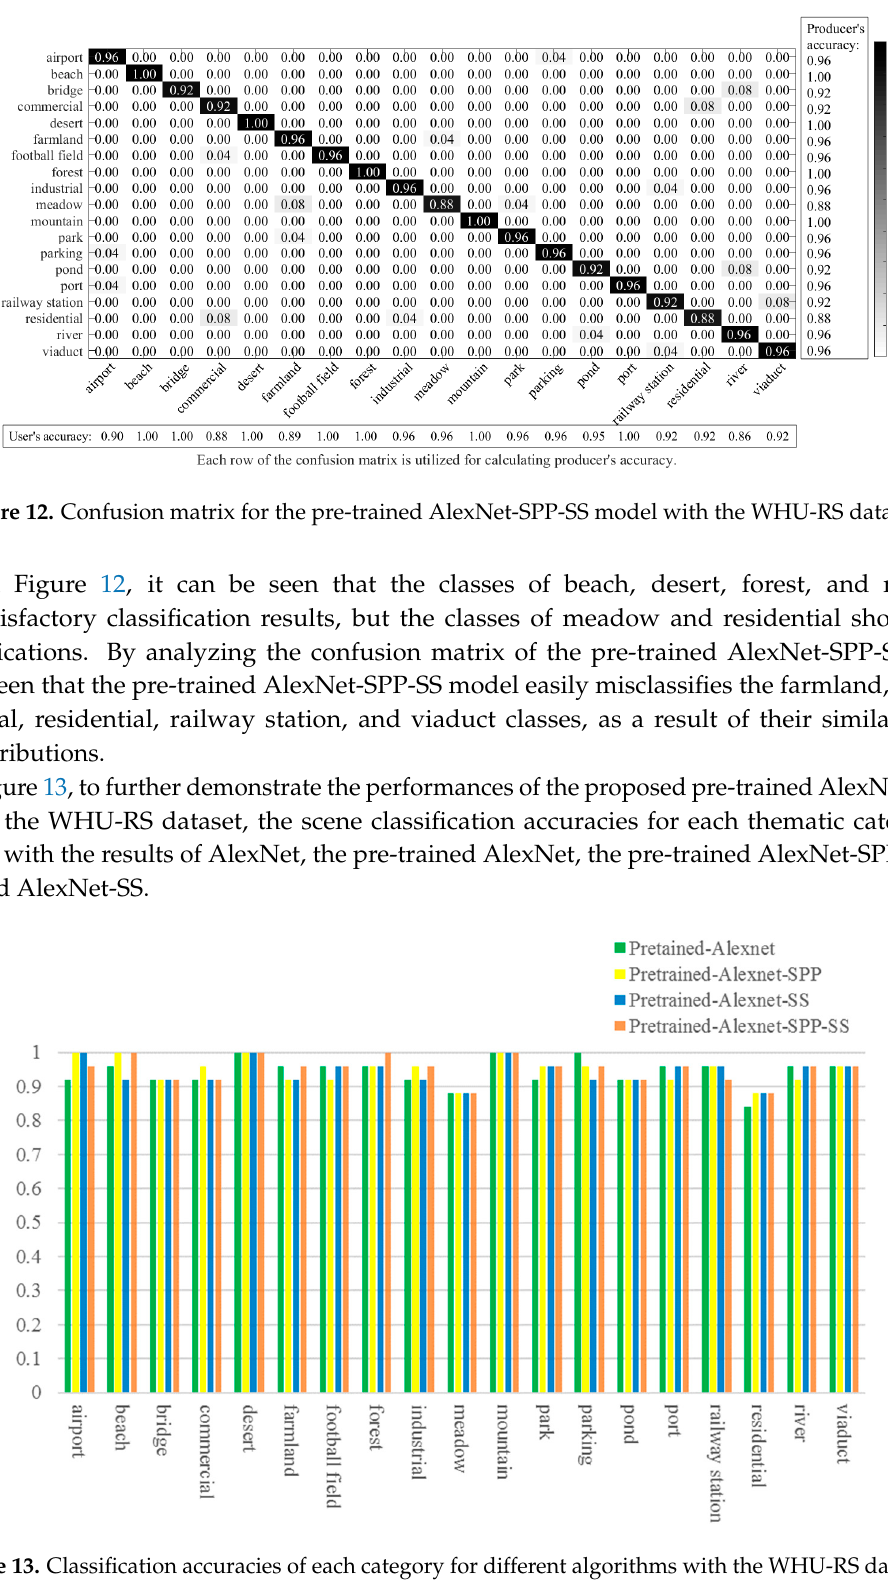
Figure 13. Classification accuracies of each category for different algorithms with the WHU-RS dataset.